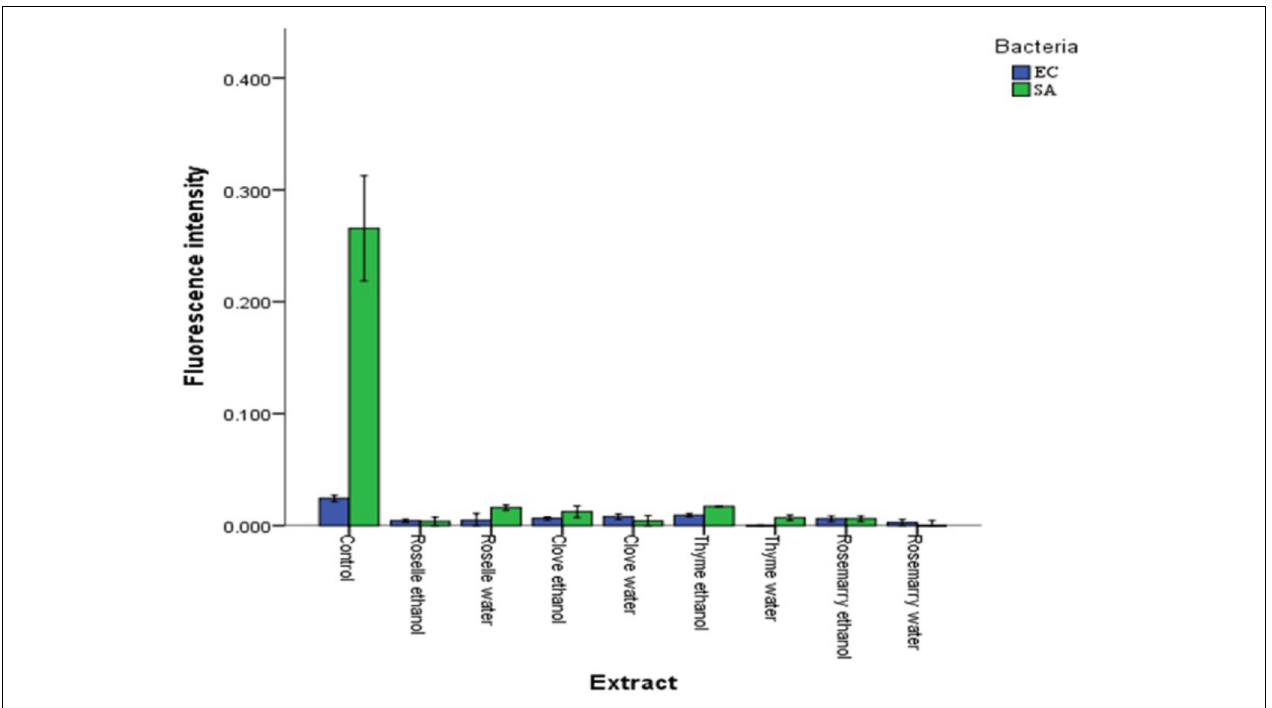
FIGURE 3 | Effects of aqueous and ethanolic extracts of Roselle, Clove, Rosemary, and Thyme on the membrane potentials of Escherichia coli (EC) and Staphylococcus aureus (SA). Values represent the means of triplicate measurements ( n = 3). Bars represent the standard